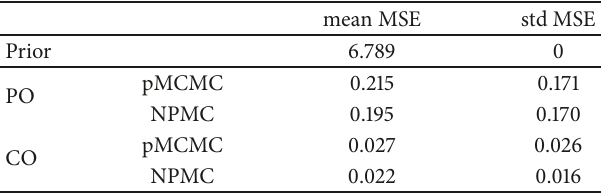
Table 1: Final mean and standard deviation (std) values of the MSE for 𝜃 1 in the CO and PO scenarios, for pMCMC and NPMC. The prior values are included for